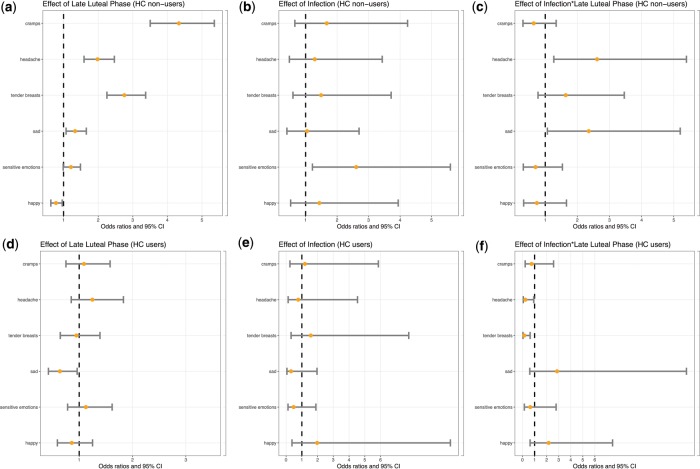
Predicted odds (circles) and 95% confidence intervals (horizontal bars) of experiencing pain and emotions during the menstrual cycle as a function of hormonal contraceptive use, the phase of the menstrual cycle and the presence of a sexually transmitted infection (STI). Among non-users of hormonal contraceptives (top panel, N = 624), (a) the odds of experiencing symptoms are higher (e.g. cramps, headache, tender breasts and sadness) or lower (i.e. happy) in the late luteal phase (−3 days to the onset of menses), as compared to the early luteal phase (dashed line); (b) the presence of an infection is associated with an increased odds of experiencing sensitive emotions throughout the luteal phase as compared with the absence of a STI (dashed line); (c) the odds of experiencing a headache and sadness in the late luteal phase is higher for individuals with a STI (N = 40) as compared with individuals without a STI (dashed line). Among users of hormonal contraceptives (bottom panel, N = 241), (d) the odds of experiencing sadness is lower in the late luteal phase as compared with the early luteal phase; (e) the odds of experiencing any of the symptoms is not modified by the presence of a STI, as compared with the absence of a STI (dashed line); (f) the presence of a STI decreases the odds of experiencing tender breasts in the late luteal phase